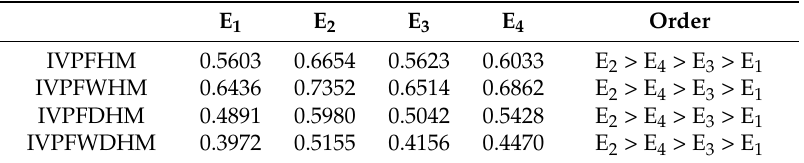
Table 2. The rank and score of the suppliers by using IVPFHM, IVPFWHM, IVPFDHM, and IVPFWDHM operators.